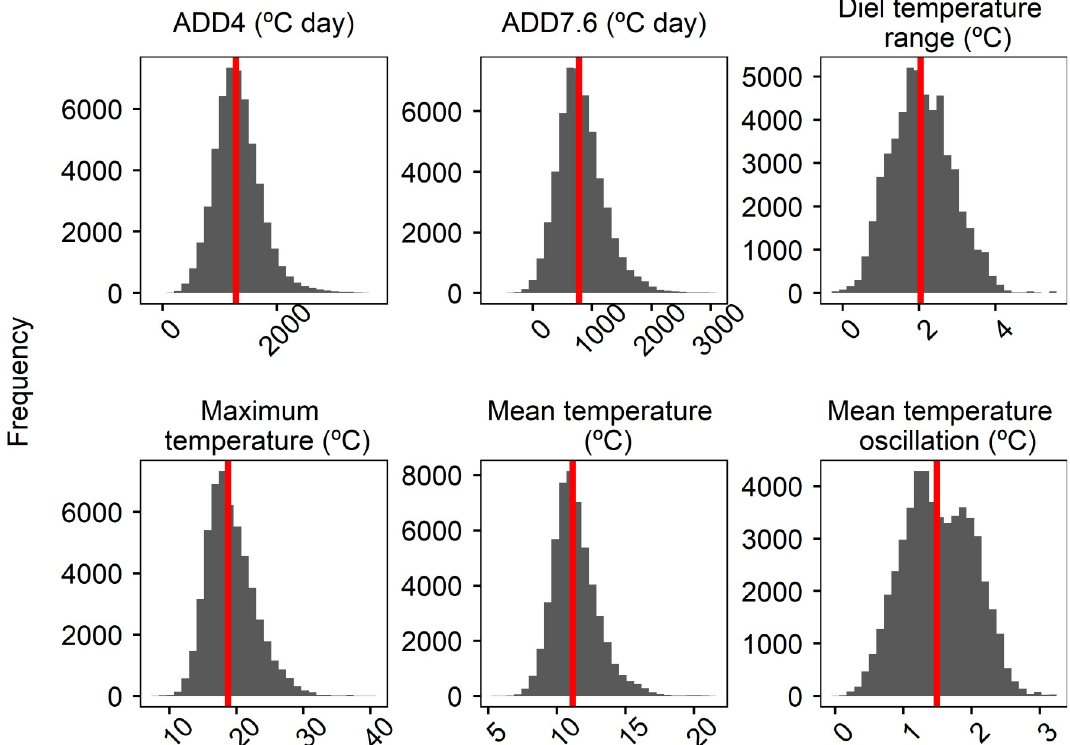
Fig 6. Projections of thermal variables for the Pyrenean lakes (n = 2,267) during the period between 2000 and